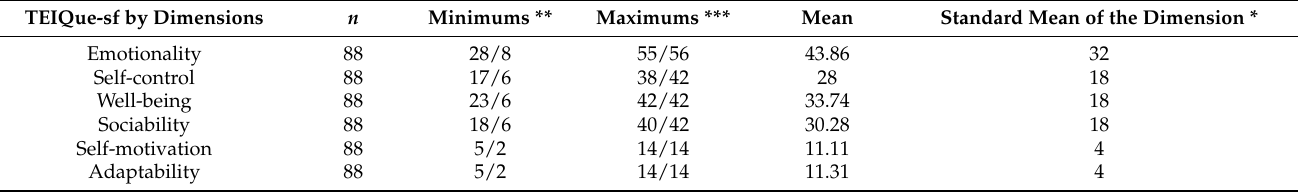
Table A3. Means and standard deviations of the TEIQue-sf scale by dimensions (taking the test totals). Source: own